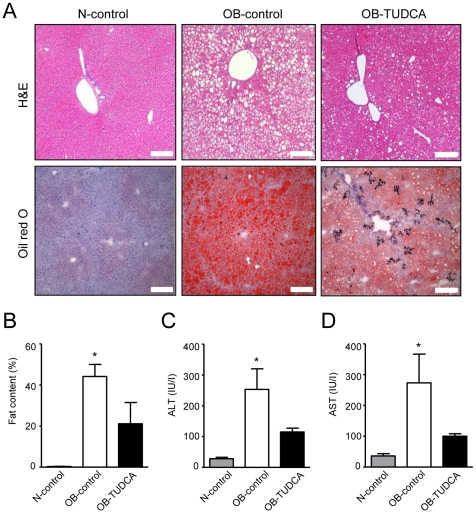
Effects of oral TUDCA treatment on hepatic steatosis in ob/ob mice.(A) H&E and oil red O staining of the liver shows a marked improvement of steatosis. Scale bars indicate 200 µm. (B) Quantified fat content in oil red O stained liver sections was lower in the OB-TUDCA group as compared to the OB-control group. (C, D) Serum ALT and AST levels tended to be lower in the OB-TUDCA group as compared to the OB-control group. In panels B, C and D, * denotes P<0.05 compared to the N-control. P-values were calculated using the Kruskal-Wallis test and Dunn's multiple comparison test.